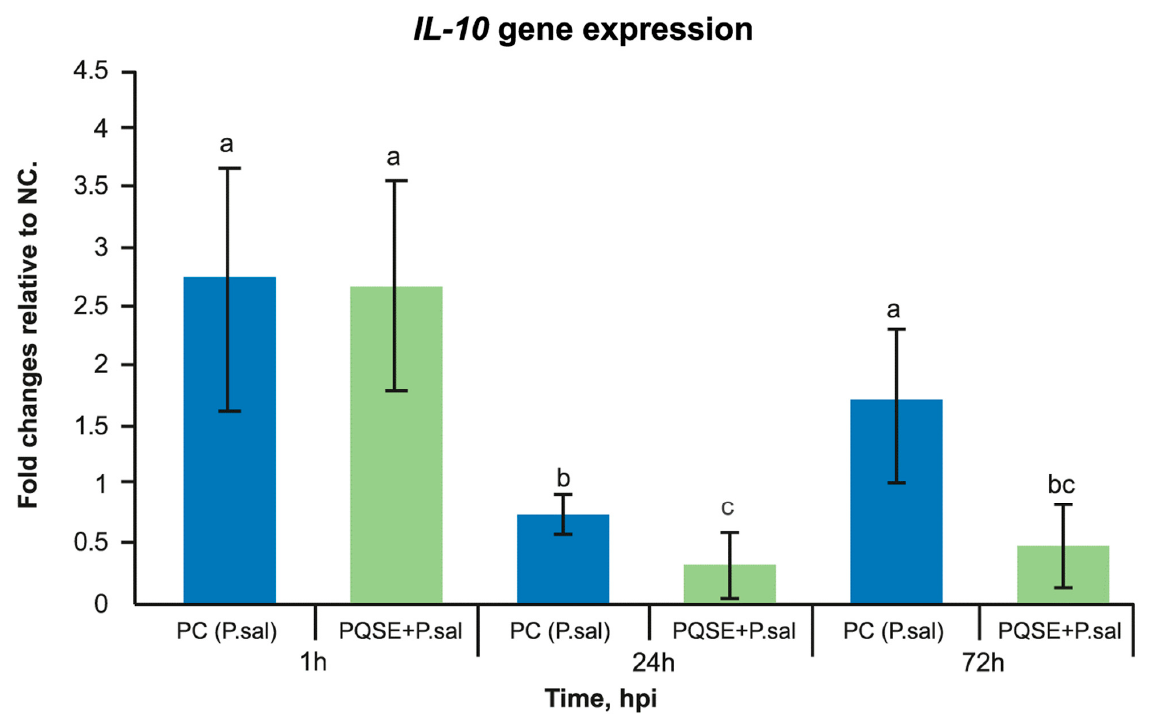
Figure 7. Gene expression analysis of IL-10 at 1, 24 and 72 hpi, in SHK-1 cells pre-treated with 0.5 µ g/mL of PQSE. SHK-1 cells pre-incubated 4 h with PQSE, prior to a challenge with P. salmonis , significantly reduced ( p < 0.05) the gene expression of Interleukin 10 (IL-10), with respect to NC and PC, at 24 and 72 hpi. The results are expressed as fold change relative to the NC, as average values of triplicate determinations. NC: Negative Control (without PQSE and without P. salmonis ); PC: Positive Control ( P. salmonis ); PQSE/ P.sal : SHK-1 cells pre-treated with PQSE and challenged with P. salmonis . Different letters, a, b and c depict statistically significant differences according to the Mann-Whitney test ( p < 0.05).